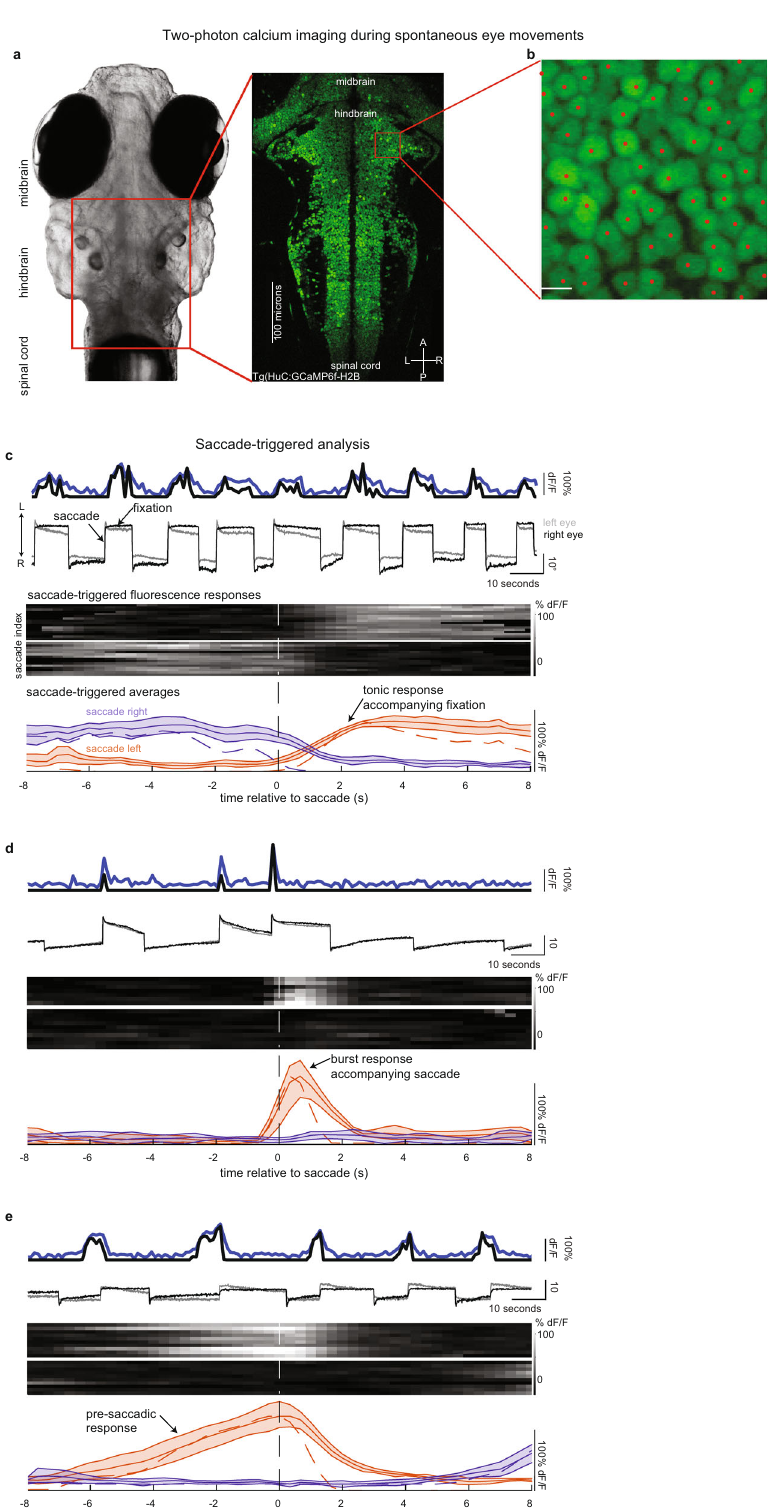
Neuronal activity dynamics associated with spontaneous sac- cades and fi xations . Approximately 19% of the spontaneously active hindbrain neurons had average activity related to eye movements. We aligned fl uorescence and deconvolved fl uores- cence responses from active cells to the times of spontaneous saccades and determined which neurons had signi fi cant saccade- triggered average (STA) activity. We treated individual fi xations